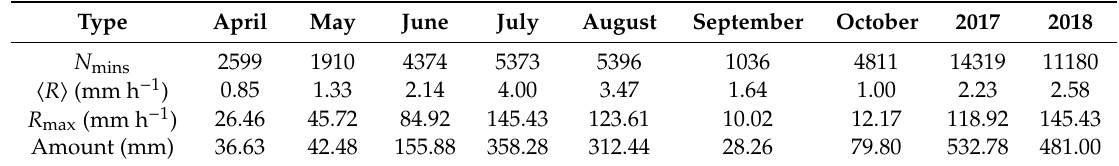
Table 1. Summary of rainfall during the experiment period.